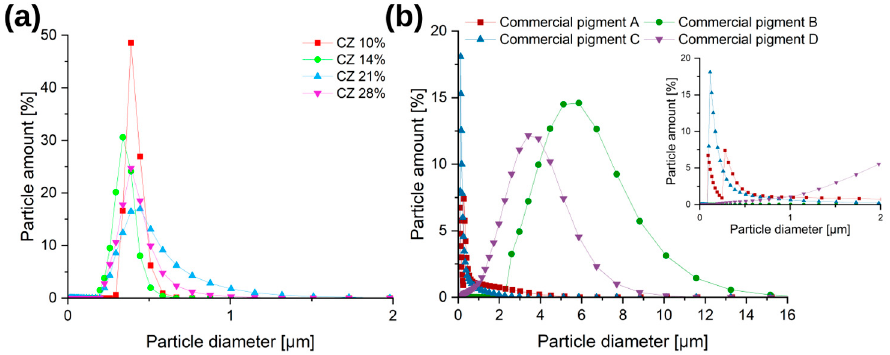
Figure 10. Pigment size distribution analysis by dynamic light scattering of ( a ) laboratory and ( b ) commercial materials.